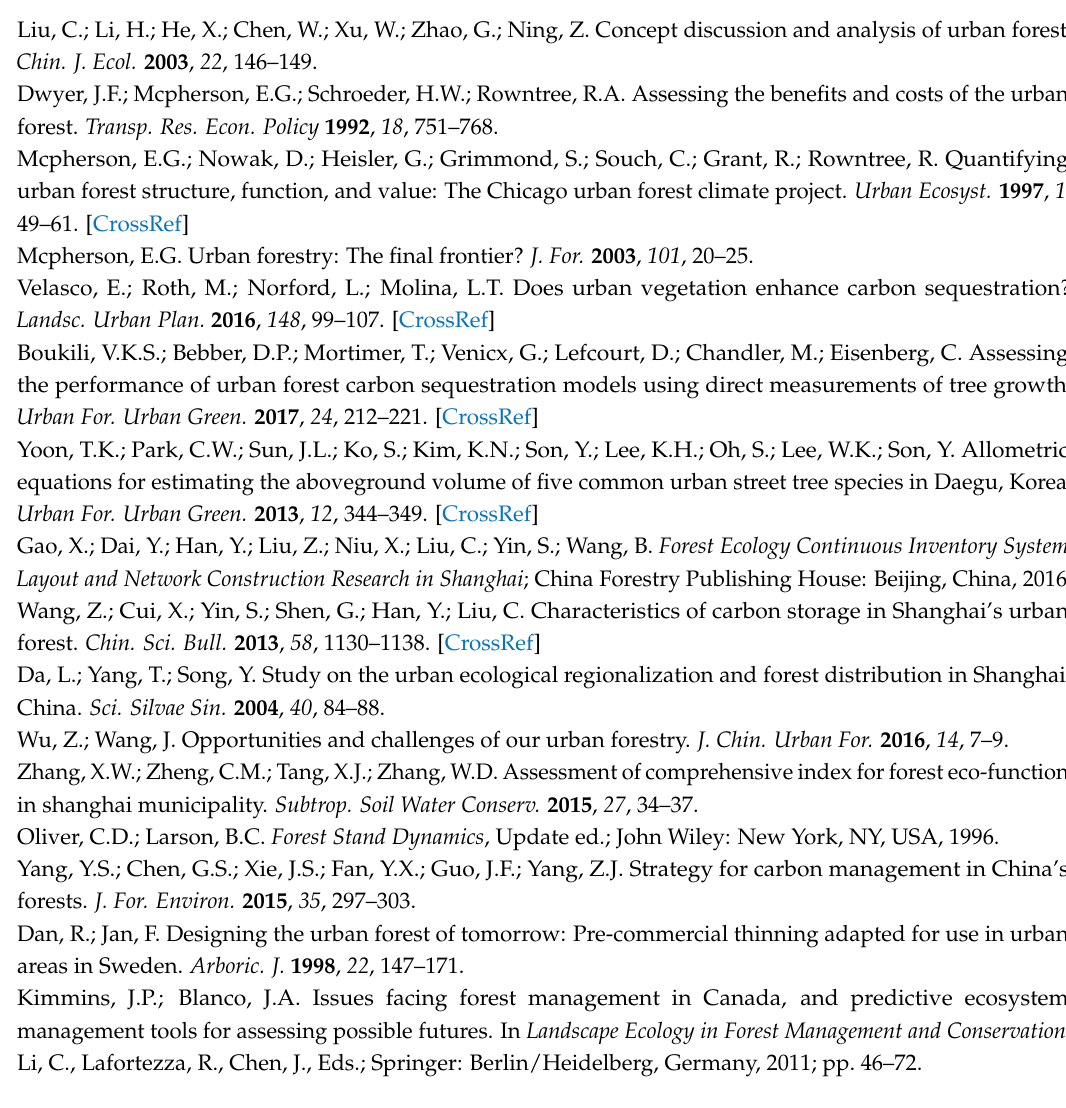
Figure S1: Study area of M. glyptostroboides plantations in SUFRN in Shanghai, Table S1: Description of M. glyptostroboides plantation plots in SUFRN, Table S2: The observed values for model